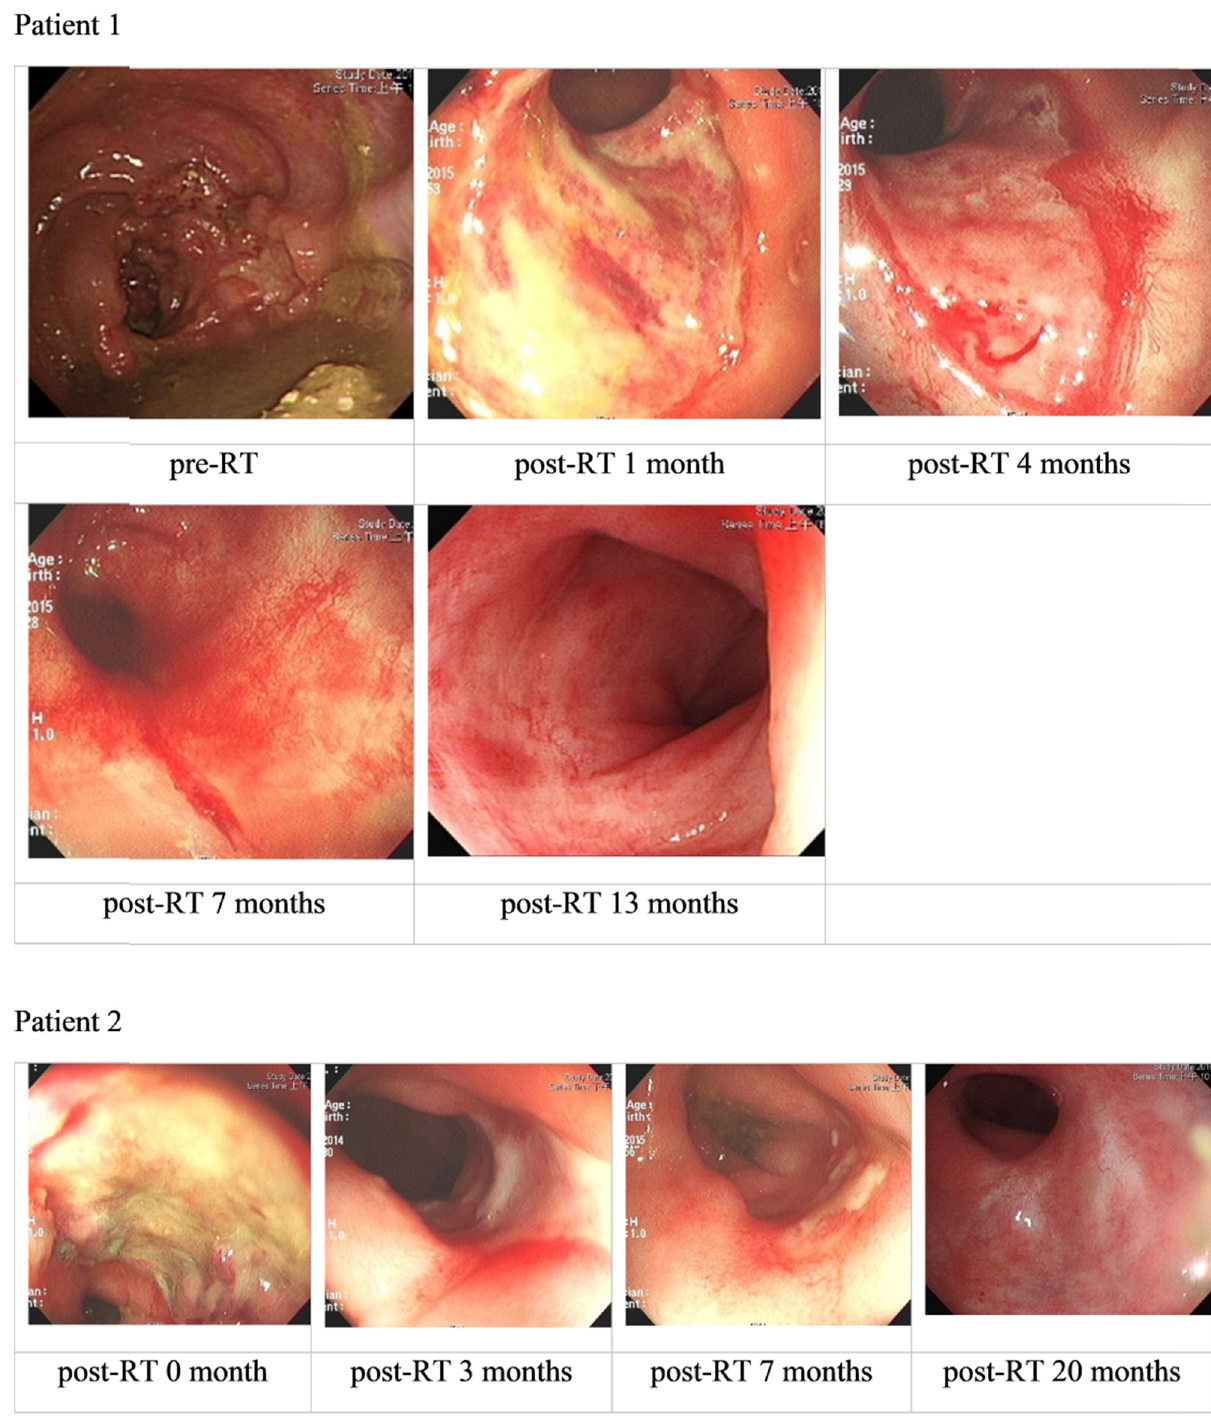
Figure 4: Patients of the W&W group with delayed white scar formations. Patient 1: Tumor was located 5 cm from the AV. Long - course RT with uracil - tegafur had delayed scar formation for approximately 1 year. No tumor regrowth occurred for 68.5 months after radiotherapy, and the patient is alive. Patient 2: The tumor was located 5 cm from the AV. Long - course RT with Xeloda had delayed white scar formation for > 7 months. No tumor regrowth occurred for 77.0 months after radiotherapy, and the patient is